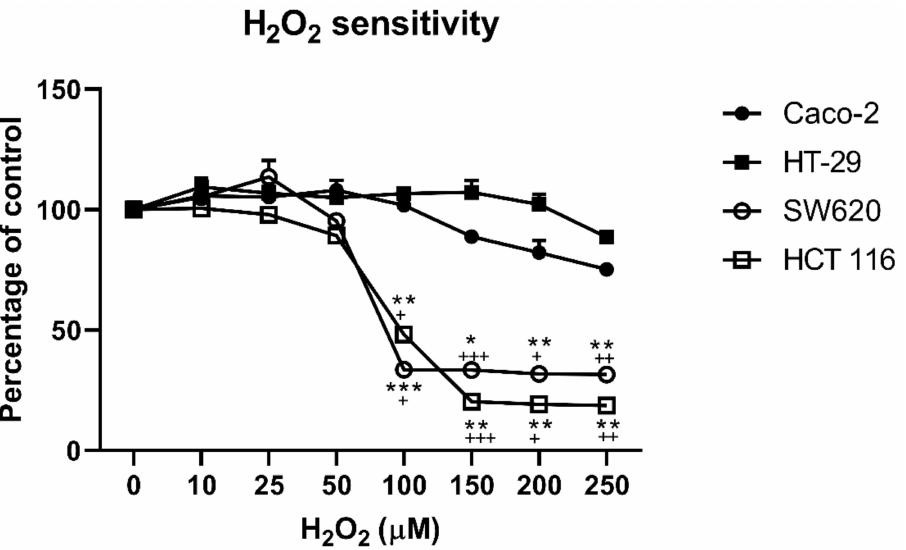
Figure 1. Viability of SW620, Caco-2, HT-29, and HCT 116 cell lines after H 2 O 2 challenge. All four cell lines were treated with a range of H 2 O 2 concentrations for 24 h, at which point their viability was measured by MTT assay. The results present the mean ± SD from three independent experiments. Significance levels: * and + p < 0.05; ** and ++ p < 0.01; *** and +++ p < 0.001. + difference between the indicated cells lines (SW620 or HCT 116, respectively) and Caco-2 cell line; * difference between the indicated cells line (SW620 or HCT 116, respectively) and HT-29 cell line.